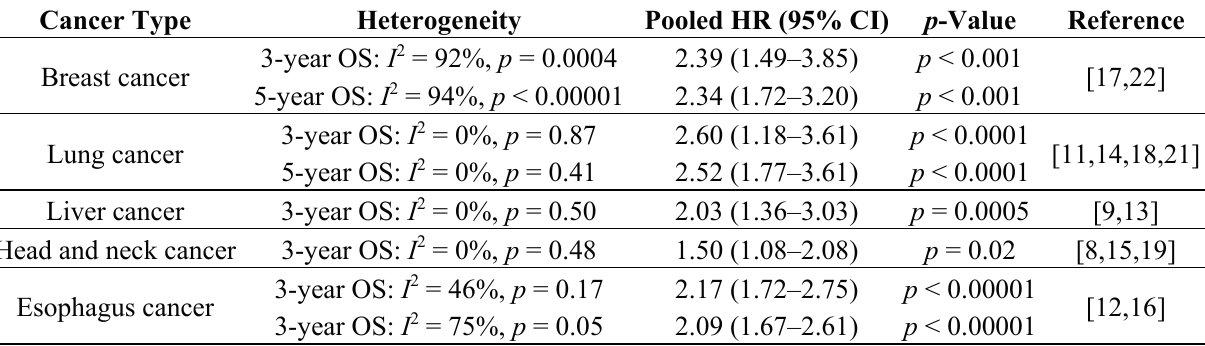
Table 3. Subgroup heterogeneity analysis of Twist-1 expression in different